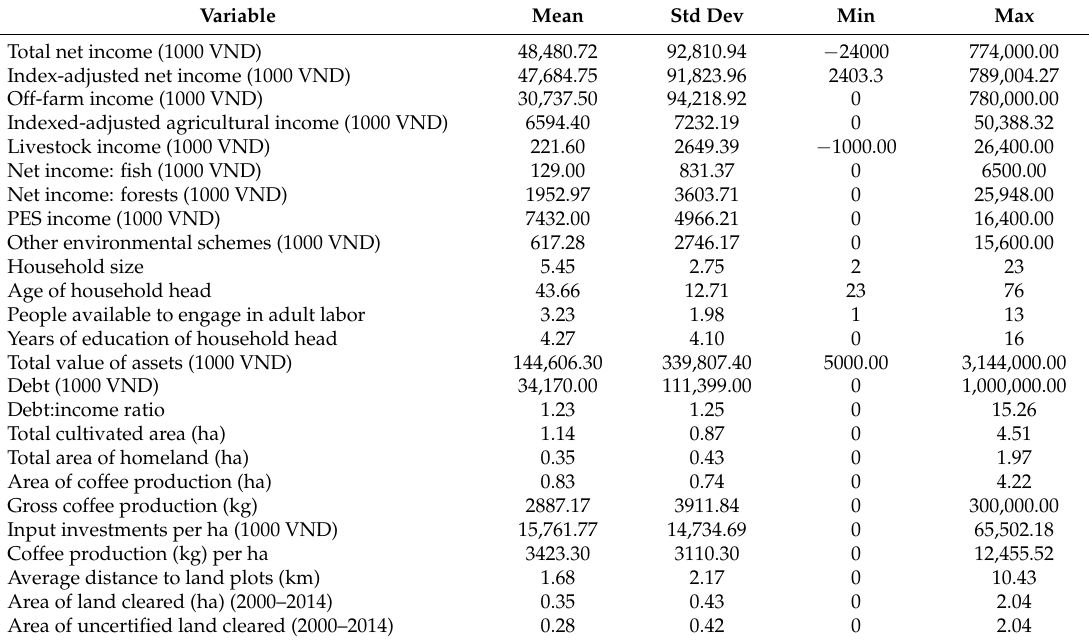
Table 1. Socio-economic assets and income sources, Da Nhim and Da Chais communes, Lam Dong Province, Vietnam, 2014 ( N =